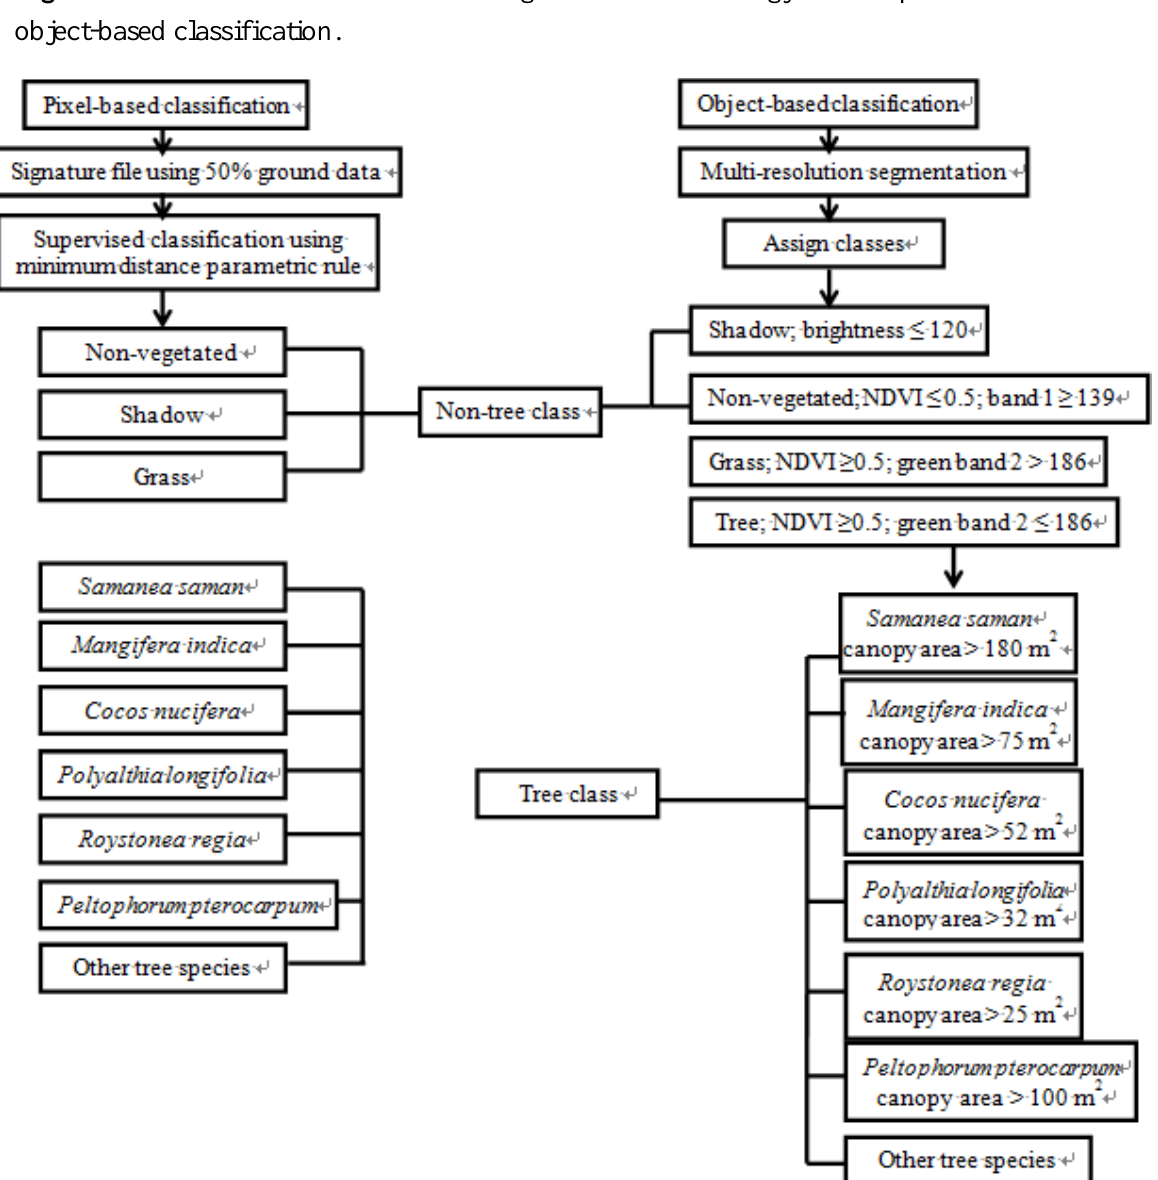
Figure 2. Flow chart summarizing the methodology for pixel-based and object-based